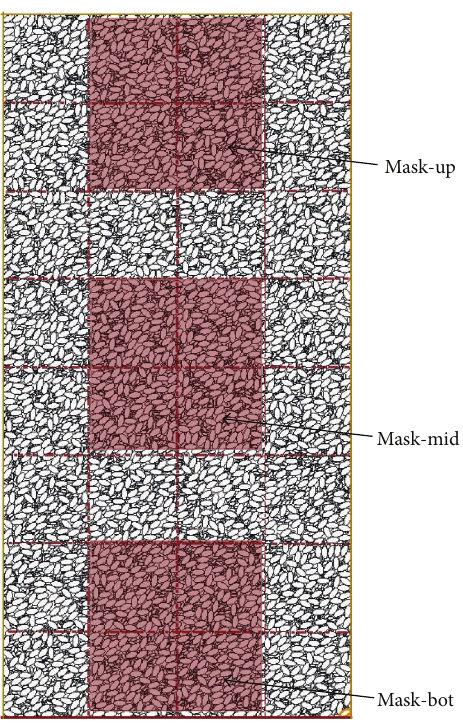
Figure 14: Definition of three different